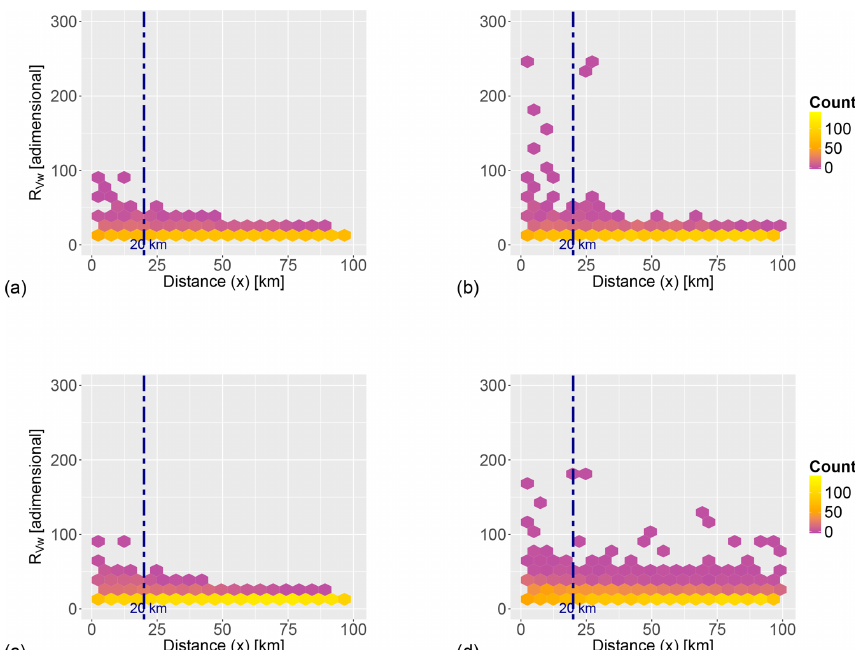
Figure 6. Heat map of the geostatistical anisotropy ratio of the wind velocity ( R V ) against distance to the coast for (a) south control transect w (near the Ebro Delta), (b) central-south transect (near Tarragona harbour), (c) central-north transect (near Mataró harbour) and (d) north control transect (near Begur cape). The elements selected to aggregate samples for the heat map are hexagons with 5km side and a scale for anisotropy of 20 units. The counts are the number of elements within a hexagon. A rough limit of the order of magnitude for the direct applicability of remote-sensing data (20km) is also shown (dashed blue line). All plots correspond to February